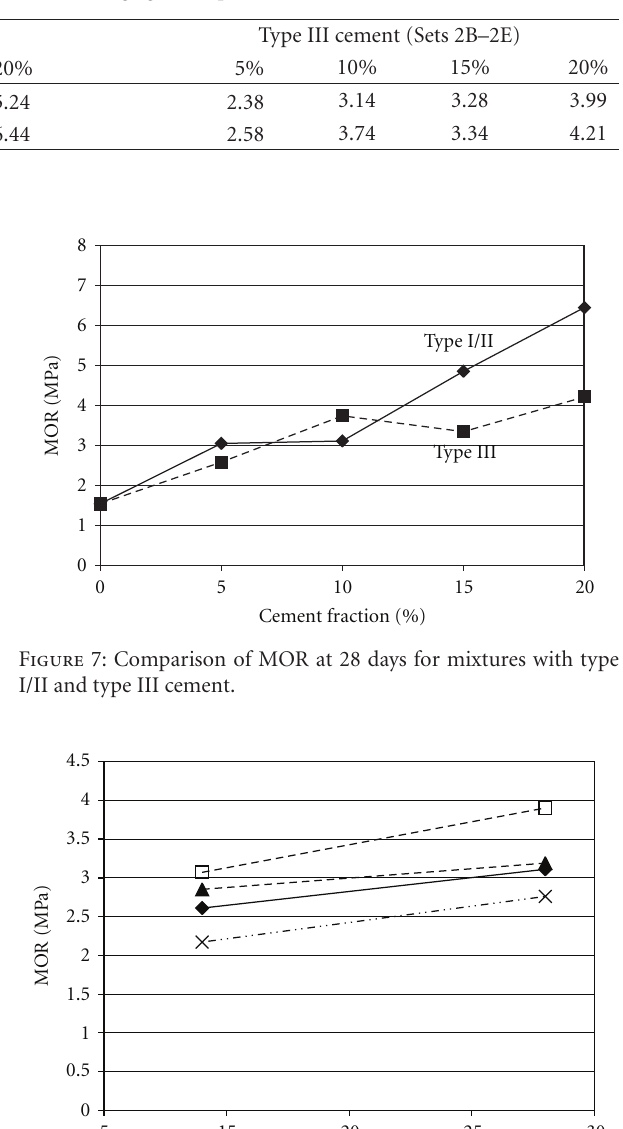
Table 7: Modulus of rupture results for di ff erent types of cement, testing ages and percents of cement added (MPa).